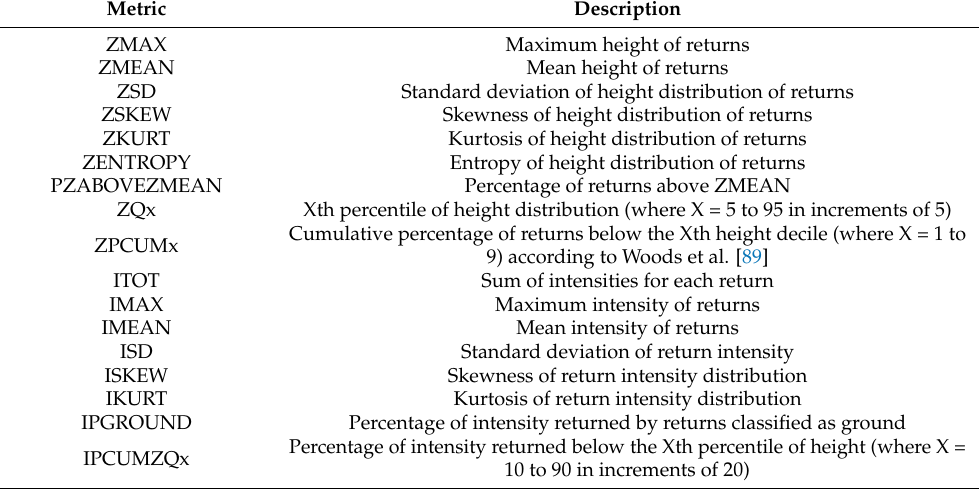
Table 3. Metrics calculated from the ULS data per